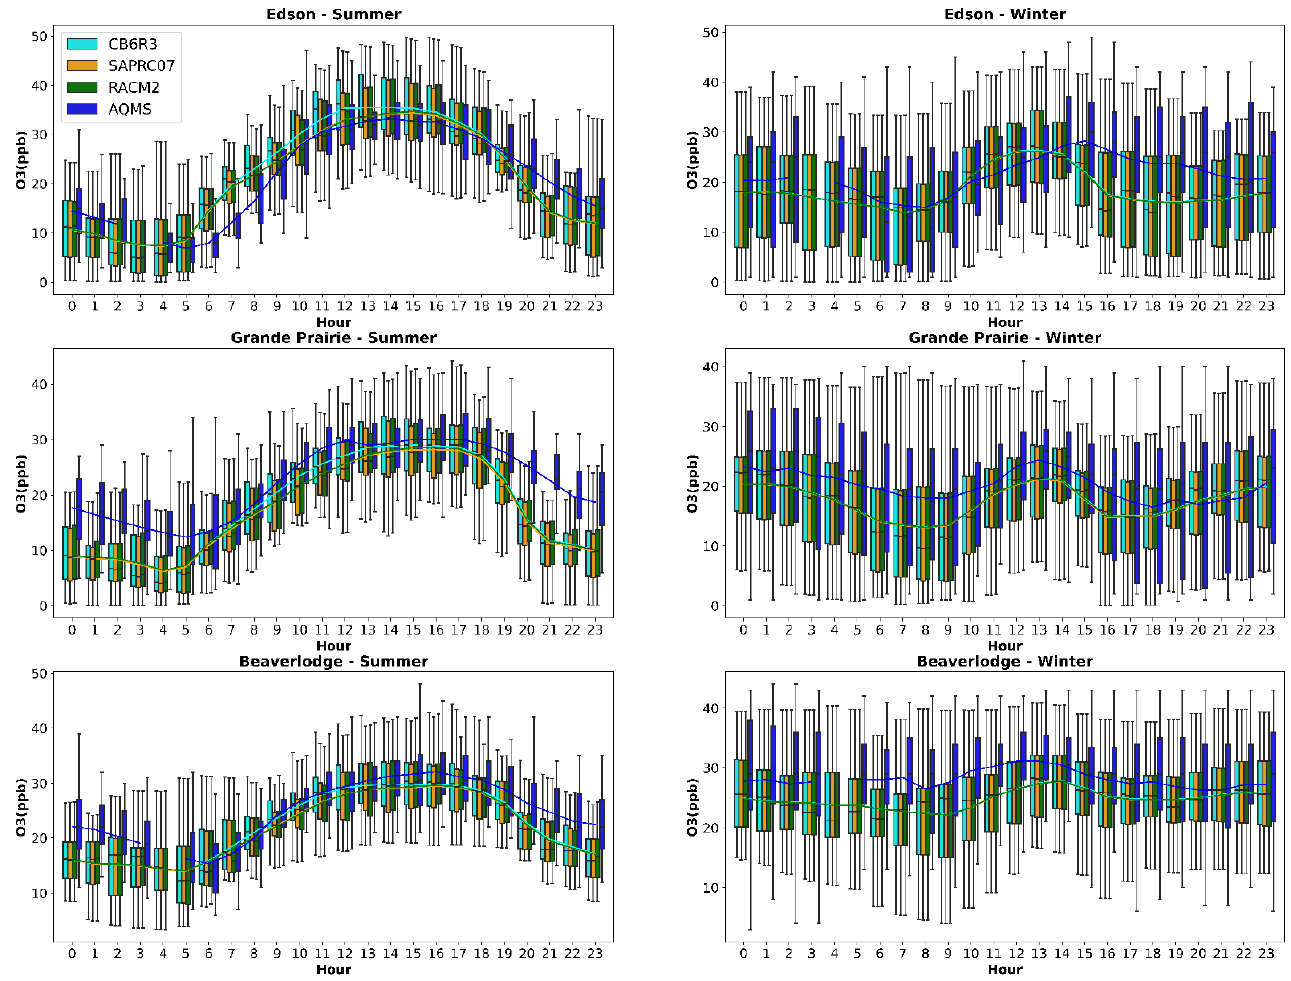
Figure 4. Diurnal variation of O 3 between three chemical mechanisms and ambient monitoring data at three monitoring stations in summer ( left panel ) and winter ( right panel ).